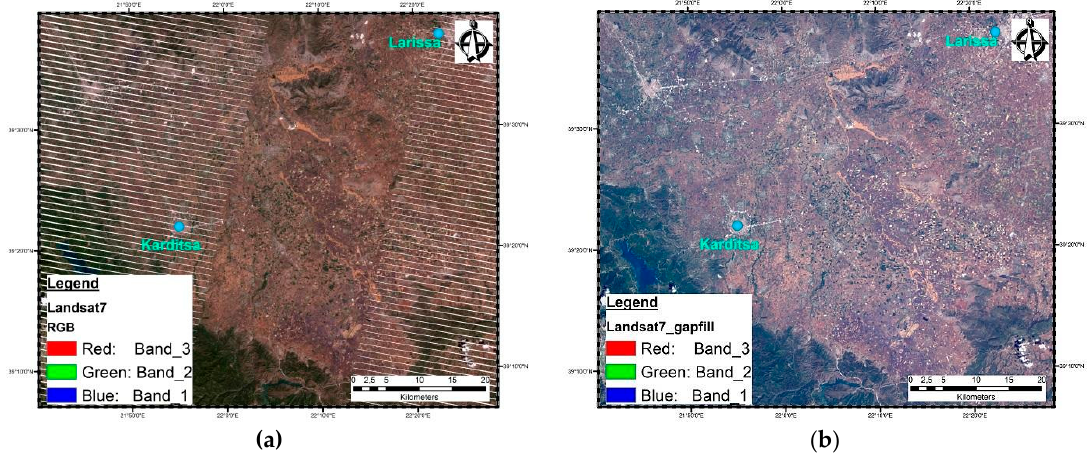
Figure 3. Filling the wedge-shaped gaps of the L7 image, ( a ) image with gaps, ( b ) corrected image.